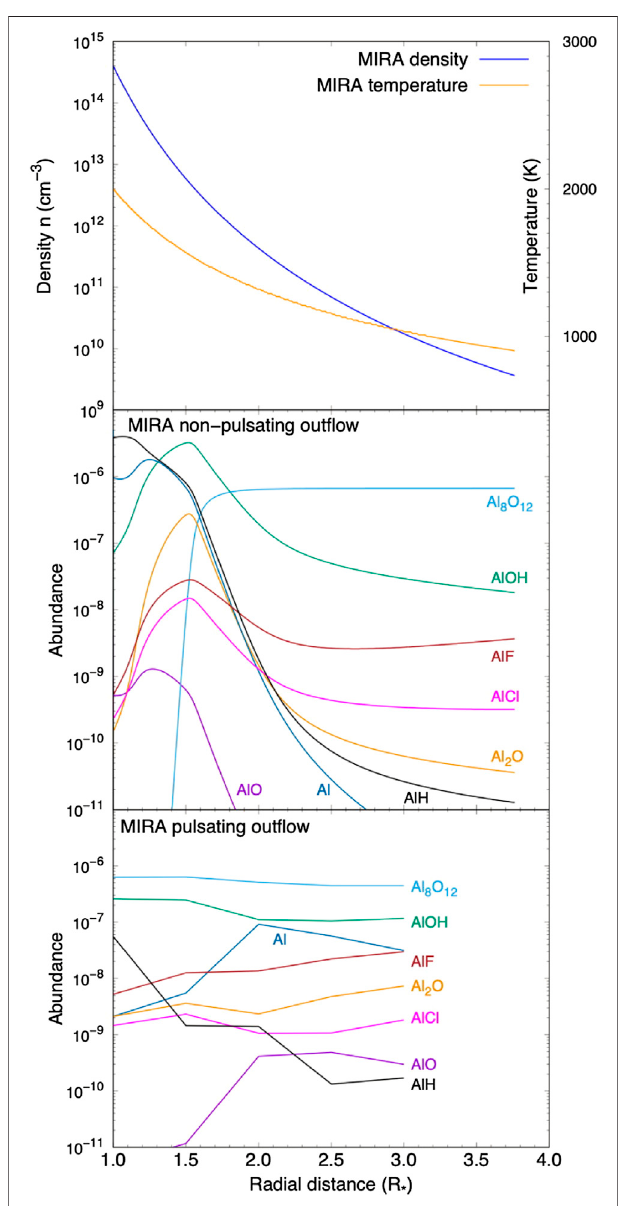
FIGURE 7 | Aluminum oxide formation in AGB out fl ows. Top panel: Temperature and density structure in a “ stationary ” wind from an AGB star. The conditions are appropriate for the prototypical Mira variable, Mira. Middle panel: calculated abundances of relevant aluminum-bearing species in this out fl ow based upon the chemical scheme outlined in Figure 4 ) . Note the rapid onset of the Al 8 O 12 cluster when the temperature reaches ≃ 1400 K. Bottom panel: Calculated abundances for a model where pulsations of the atmosphere are taken into account. Figure adapted from (Gobrecht et al., 2022)